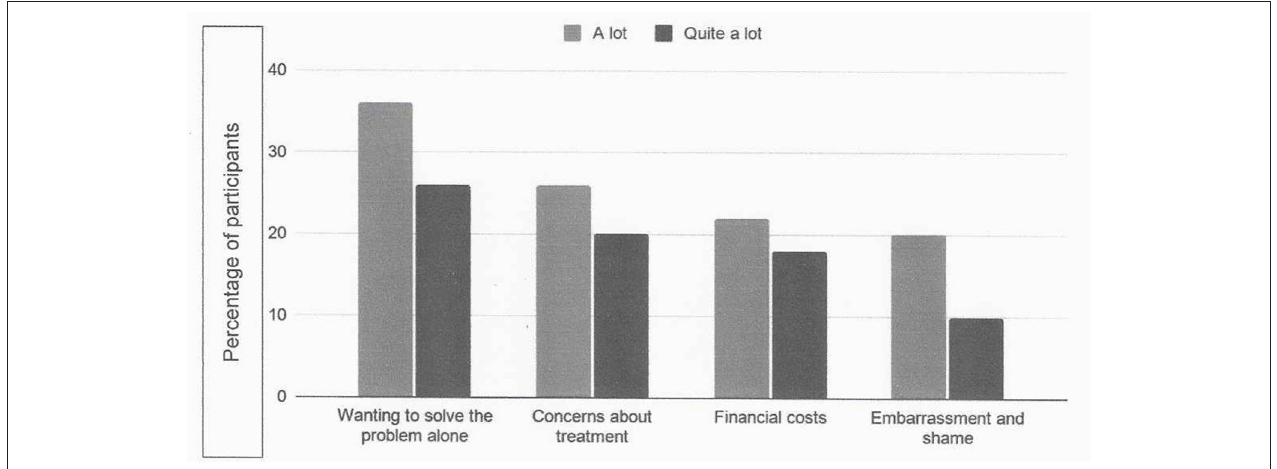
FIGURE 1 | Top four barriers to help-seeking in the sample of individuals with OCD.